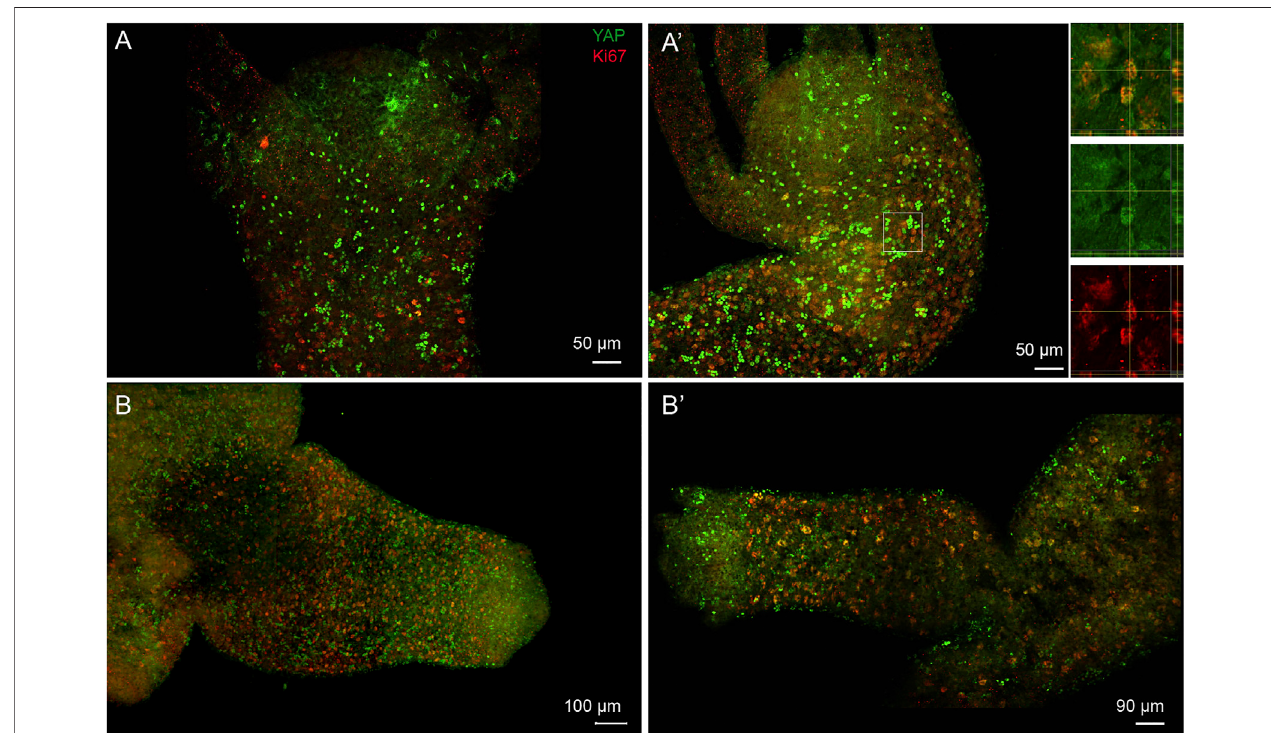
FIGURE 8 | Subset of nuclearized YAP positive cells are actively proliferating cells and are actively recruited to the developing bud. Immuno fl uorescence assay of Hvul_YAPperformed usinganti-CheYkiantibodyand proliferatingcellpopulationusingKi67markershowingcolocalizationofasubsetofYAP positivecells.Theimages shown here aremaximum intensity projections. (A , A ’ ) This panel shows the head and shoulder region of thepolyp showing brightlystained nuclearized YAP expressing cells are not actively proliferating. The individual cells expressing YAP in the outer hypostomal region are also non-proliferative. The white square in fi gure (A 9 ) is enlargedintheinsetsshownontherightofthe fi gure.ThetopinsetshowsthetissuefromaX-YplaneinthecentrewithorthogonalslicesofY-ZandX-Zplaneindicatedin rightand belowrespectively.Theregionofinterestwhereinoneofthecellsshowingcolocalizationiscon fi rmedontheX-Y-Zaxes.Middleinsetshowsthesameimagein green channel (YAP) and lower inset shows the red channel (Ki67). (B , B ’ ) The budding polyps showing active incorporation ofproliferative cells into the developing bud. These cells co-stain with Hvul_YAP suggesting their colocalization. Panel (B) clearly shows small and dense localization of actively proliferating cells being recruited into the newly forming bud in early stages. The panel (B 9 ) shows a mature bud where the tentacles have started forming and the active recruitment of cells into the bud body hasreduced.Hence,theKi67expressingcellsarelargerinsizeandlessdense.( N (cid:2) 3),Red:Ki67&Green:YAP.(Scalebar:AandA ’ ,50 μ m,B,100 µmandB ’ ,90